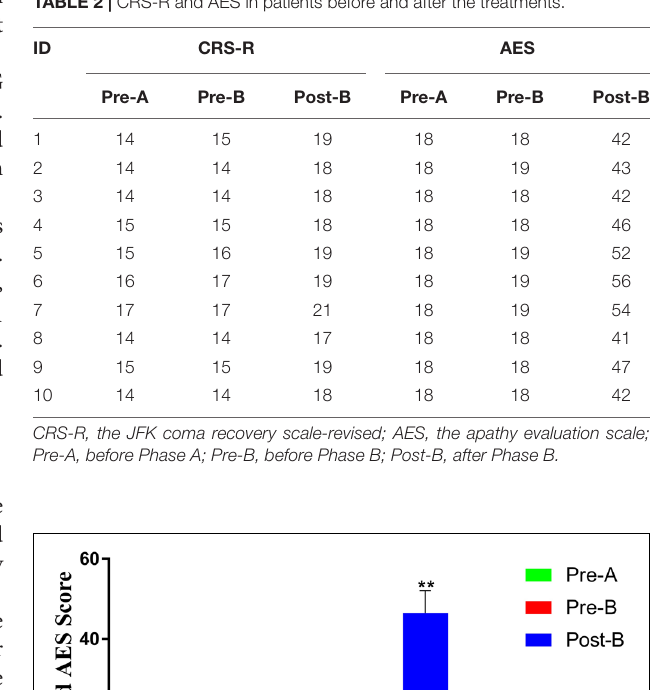
TABLE 2 | CRS-R and AES in patients before and after the treatments.